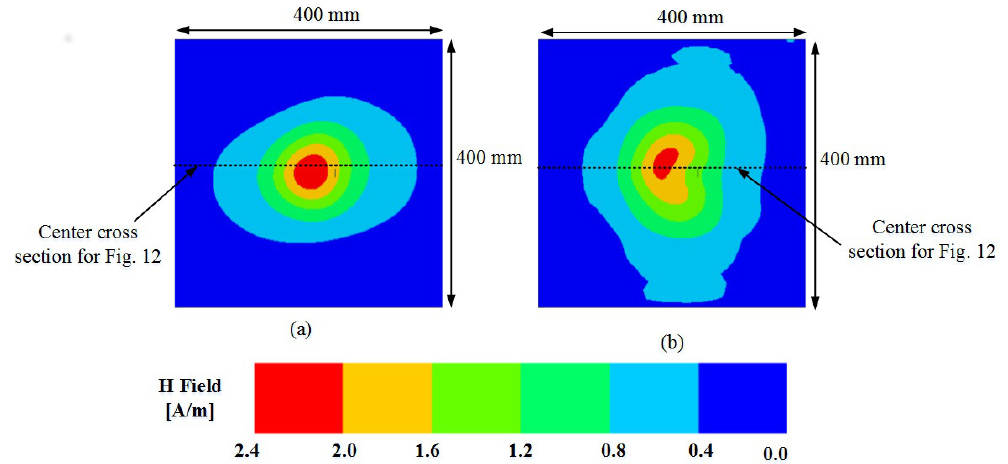
Figure 11. Simulated H-field distribution with input power of 15 W ( a ) H-field probe for 1.2–1.4 GHz at the center frequency of 1.3 GHz, ( b ) H-field probe for 2.7–3.1 GHz at the center frequency of 2.9